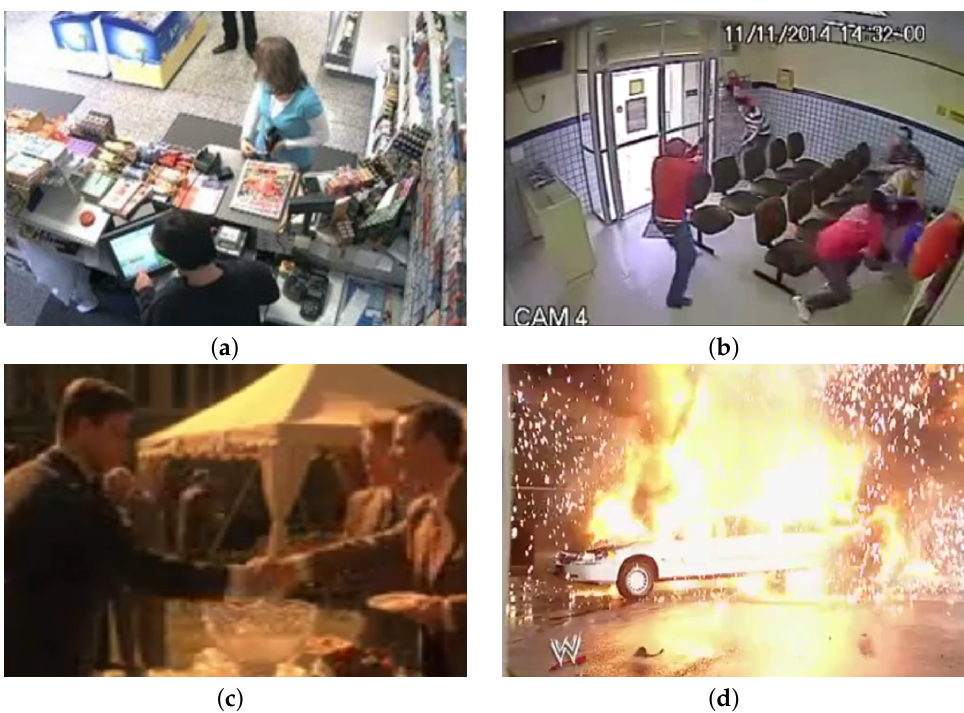
Figure 4. Comparison between normal and abnormal frames extracted from real-world anomalies datasets. ( a ) Frame from a normal activity extracted from UCF-Crime [40]. ( b ) Abnormal frame from UCF-Crime [40], showing a shooting. ( c ) Frame from a normal activity in XD-Violence [59]. ( d ) Abnormal frame from XD-Violence [59], representing an